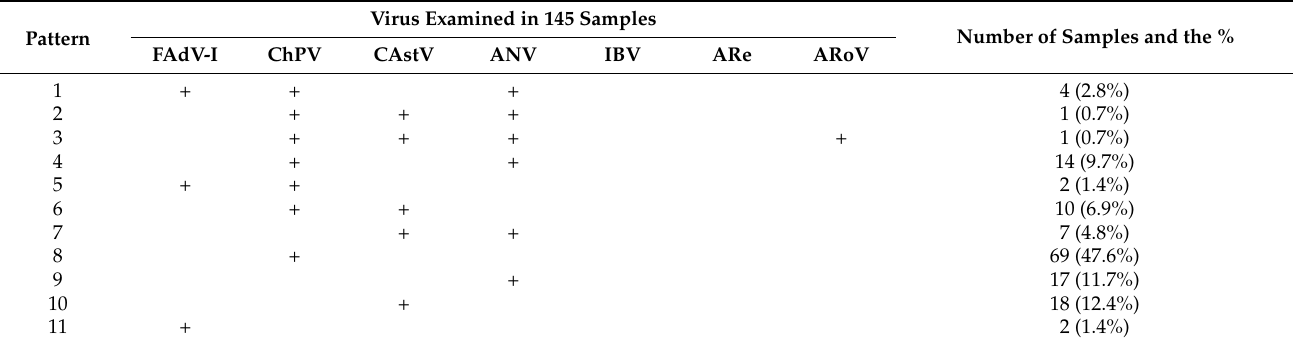
Table 5. Enteric virus detection patterns from 145 positive samples in the small intestines from chicken commercial